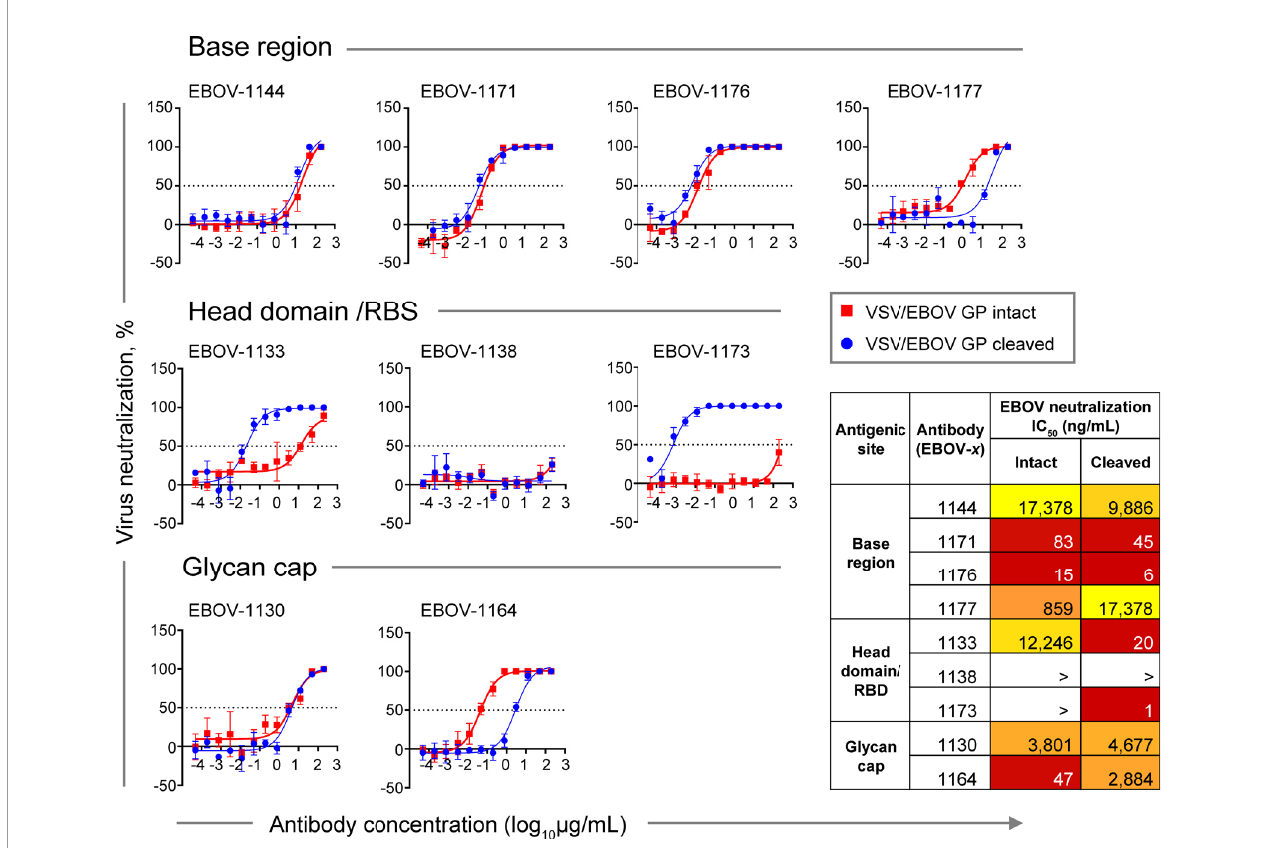
FIGURE 6 | Neutralizing potency by class-representative plasma antibodies. Dose-response neutralization of recombinant infectious vesicular stomatitis virus (VSV) expressing EBOV GP in place of the endogenous VSV glycoprotein (VSV/EBOV GP). Curves for intact VSV/EBOV GP neutralization are shown in red, and curves for thermolysin-cleaved VSV/EBOV GP neutralization that generates virus surface-exposed cleaved GP (de fi ned as VSV/EBOV GP CL ) are shown in blue. Half maximal inhibitory concentration (IC 50 ) was estimated using nonlinear regression analysis. Mean ± SD of technical triplicates from one experiment are